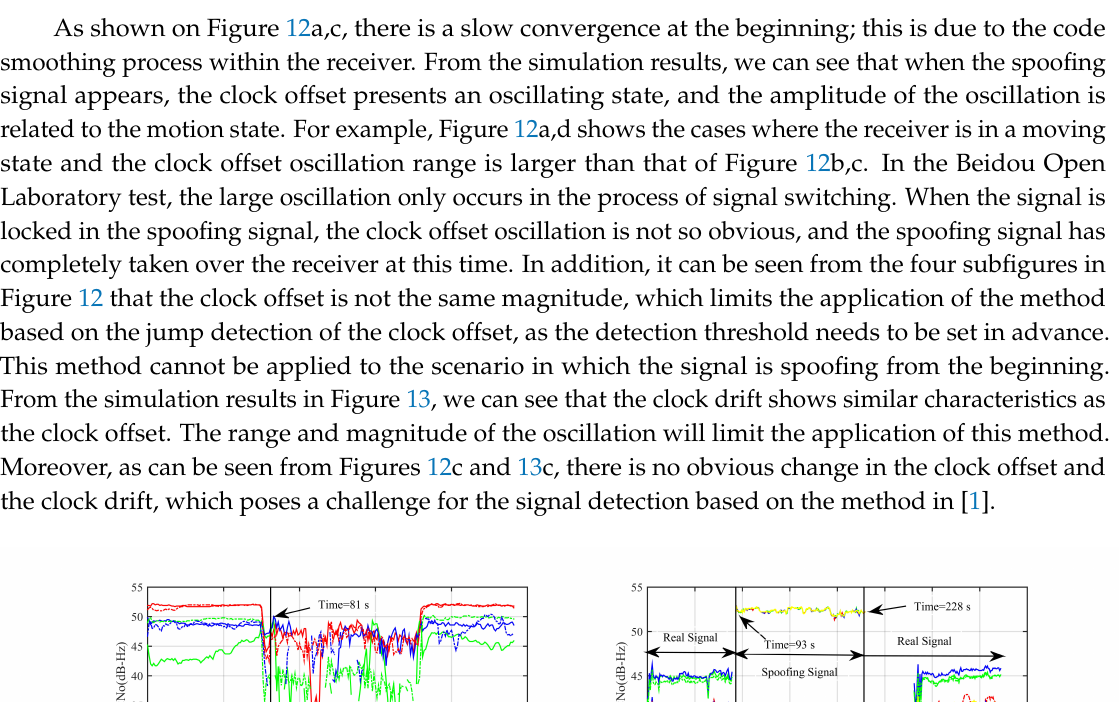
Figure 13. Curve of the clock drift in different experimental scenarios.